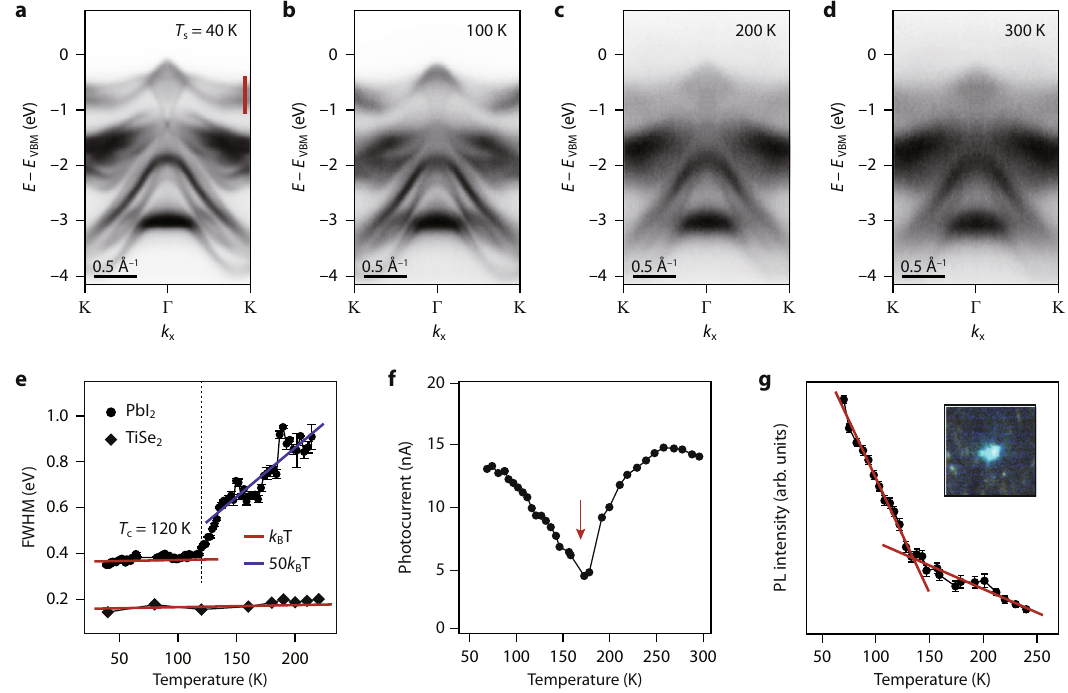
Fig. 2 | Order-disorder phase transition and its effect on material properties. a – d SeriesofARPESdatatakenat T s markedattheupperrightofeachpanel.These data were taken in k x with the photon energy of 96eV. e FWHM plotted as a functionof T s ,obtainedbyacurve fi ttoenergy-distributioncurvestakenalongthe redlinein a .RedandbluelinesoverlaidaretherateofincreaseinFWHMexpected for k B T and 50 k B T , respectively. The dotted line shows the T c of 120K. The same analysis applied to our ARPES spectra taken from 1T-TiSe 2 , where the order-order